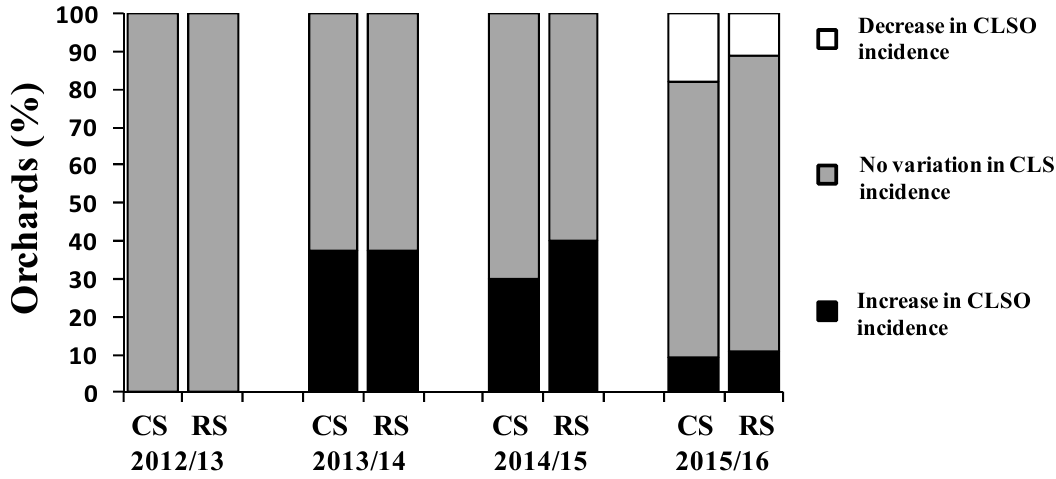
Figure 6. Four-season response of the conservative and risky strategies (CS and RS, respectively) in comparison to the traditional strategy used as the control. The percentage of orchards in which the incidence of cercospora leaf spot (CLSO) decreased (white area), remained (grey area) or increased (black area), based on Dunn test ( P = 0.05), with respect to the traditional strategy is shown. During the trial period, the average CLSO incidence in all orchards ranged from 0.04%